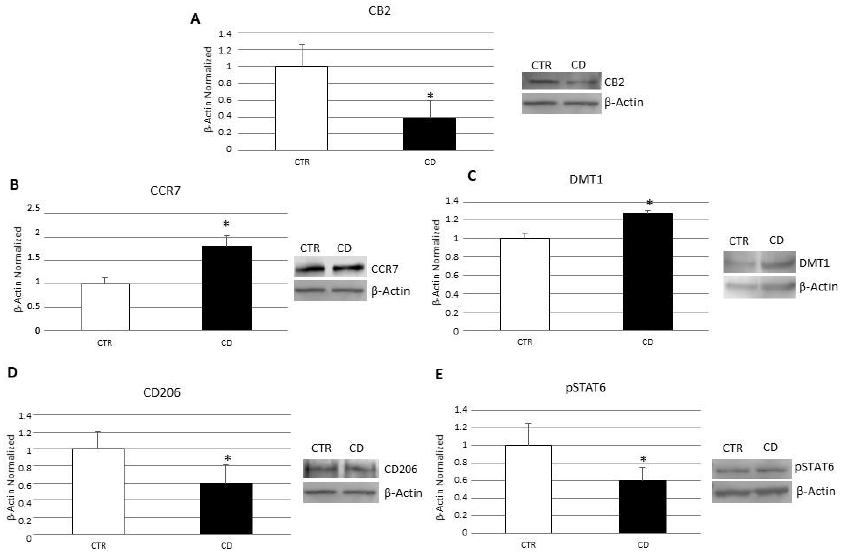
Figure 1. Characterization of CD macrophages. CB2 ( A ), CCR7 ( B ), DMT1 ( C ) CD206 ( D ) and pSTAT6 ( E ) protein levels, determined by Western Blot loading 15 µ g of total lysate, in macrophages from 5 celiac disease (CD) patients compared with macrophages from 5 healthy donors (CTR). The most representative images are displayed. Image Studio Digits software has been used to detect protein bands. The intensity ratios of immunoblots compared to CTR, considered 1, were quantified after normalizing with respective controls. The histograms represent the relative quantification for CB2, CCR7, DMT1, CD206 and pSTAT6 expression, normalized for the housekeeping protein β -Actin, as mean ± SD of independent experiments on each individual sample. A t -test has been used for statistical analysis. * Indicates p ≤ 0.05 compared to CTR.